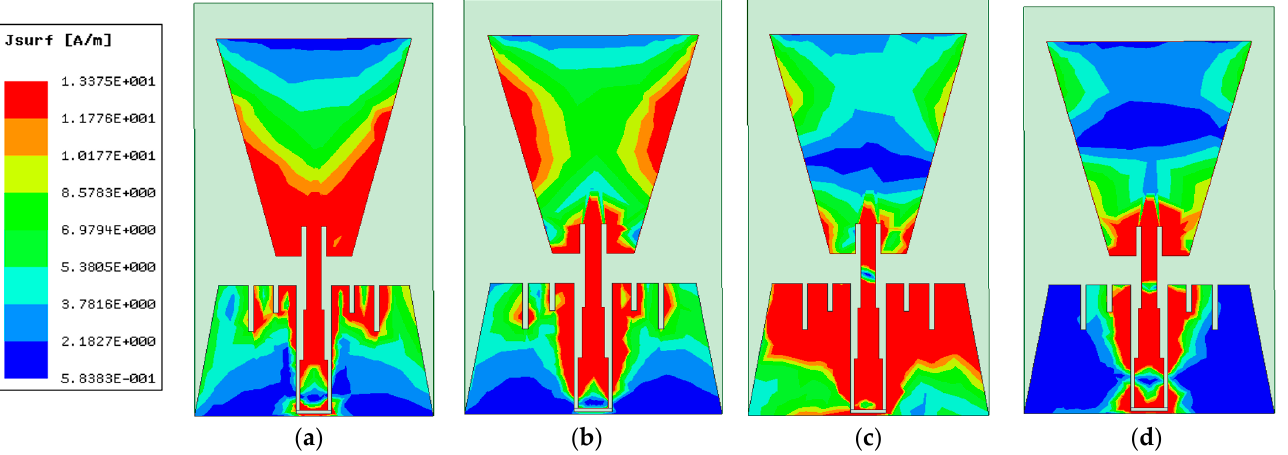
Figure 11. Current distribution at different frequencies: ( a ) 2.5 GHz, ( b ) 5 GHz, ( c ) 7.5 GHz, and ( d ) 10 GHz. ( d ) 10